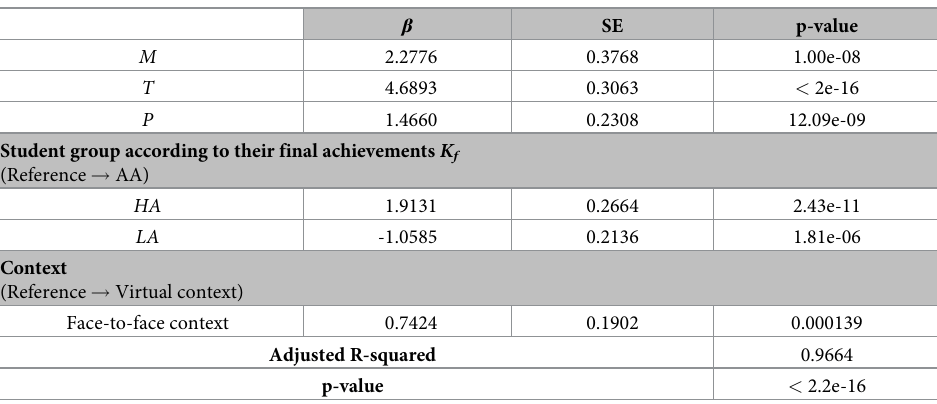
Table 7. Regression results of multiple linear model of Eq